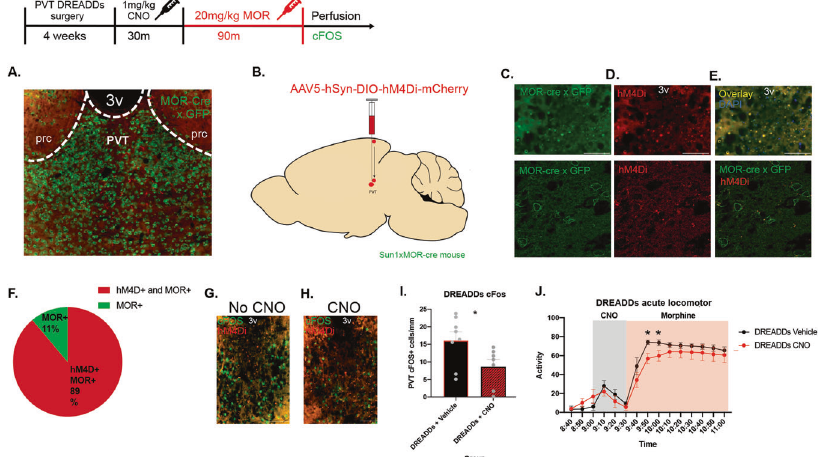
Fig. 5 DREADD inhibition of neurons in the PVT that express mu-opioid receptors. A Representative image of mu-opioid receptors in the PVT with MOR Cre x GFP reporter mouse. B Virus strategy to target PVT MOR-expressing neurons. A Cre-dependent inhibitory DREADDs construct was injected into the PVT of mice that express Cre recombinase on the nucleus of mu-opioid receptor-expressing neurons. C Mu- opioid receptor-expressing neurons identi fi ed by GFP reporter in the PVT at 10× and super-resolution. D hM4Di expression in the PVT identi fi ed by mCherry reporter at 10× and super-resolution. E Overlay of MOR-expressing neurons in green and DREADDs construct in red at 10× and super-resolution. F quanti fi cation of transfection of MOR + neurons in the PVT that also express hM4Di. G Representative image of cFOS expression in the PVT of mice injected with the DREADDs virus. H Representative image of cFOS expression in the PVT of mice injected with the DREADDs virus after i.p. CNO injection. I Quanti fi cation of cFOS expression in the PVT to show DREADD inhibition from CNO. J Activity plot per 10 m bins of mice that received CNO or saline injection with a morphine stimulus. Scale bars represent 100 μ